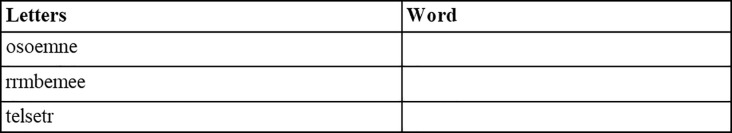
Anagram task.Example of tasks. Note the third task has multiple solutions. Participants only had to find one and were not rewarded for finding more than one. No participants submitted more than one answer to any of the anagram tasks.